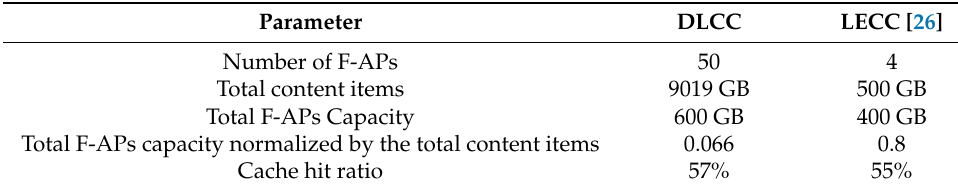
Table 9. Comparison between DLCC and learning-based cooperative caching (LECC) approach on the basis of cache hit ratio.